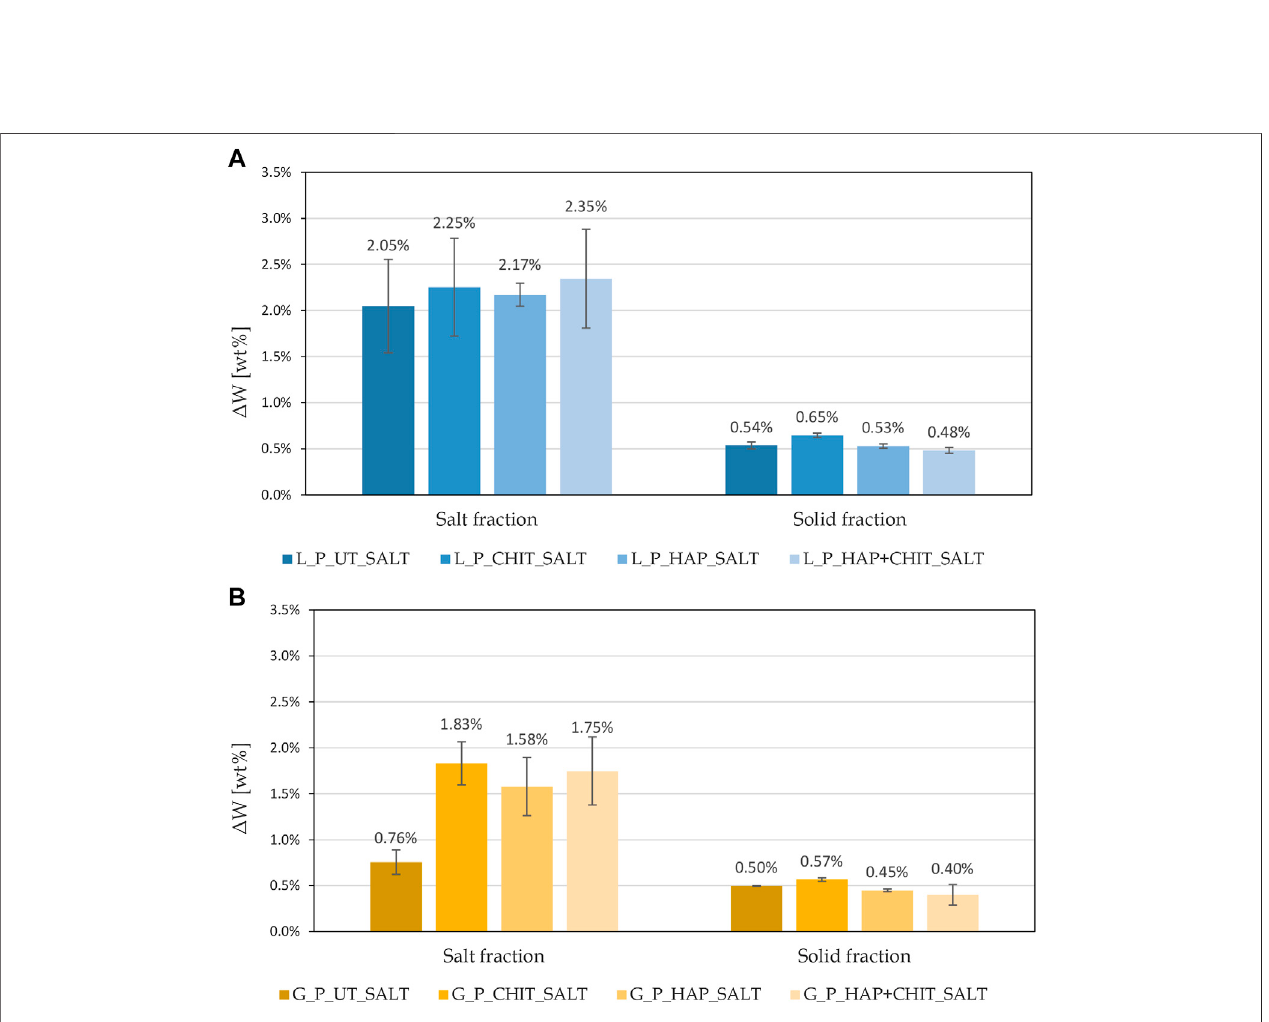
FIGURE12| Weightpercentagesofsaltfractionandsolidfractionindebris,referredtotheinitialweightoftheprismaticsamples,obtainedafterbrushingattheend of the fi rst absorption test, for: (A) Lecce stone and (B) Globigerina limestone.